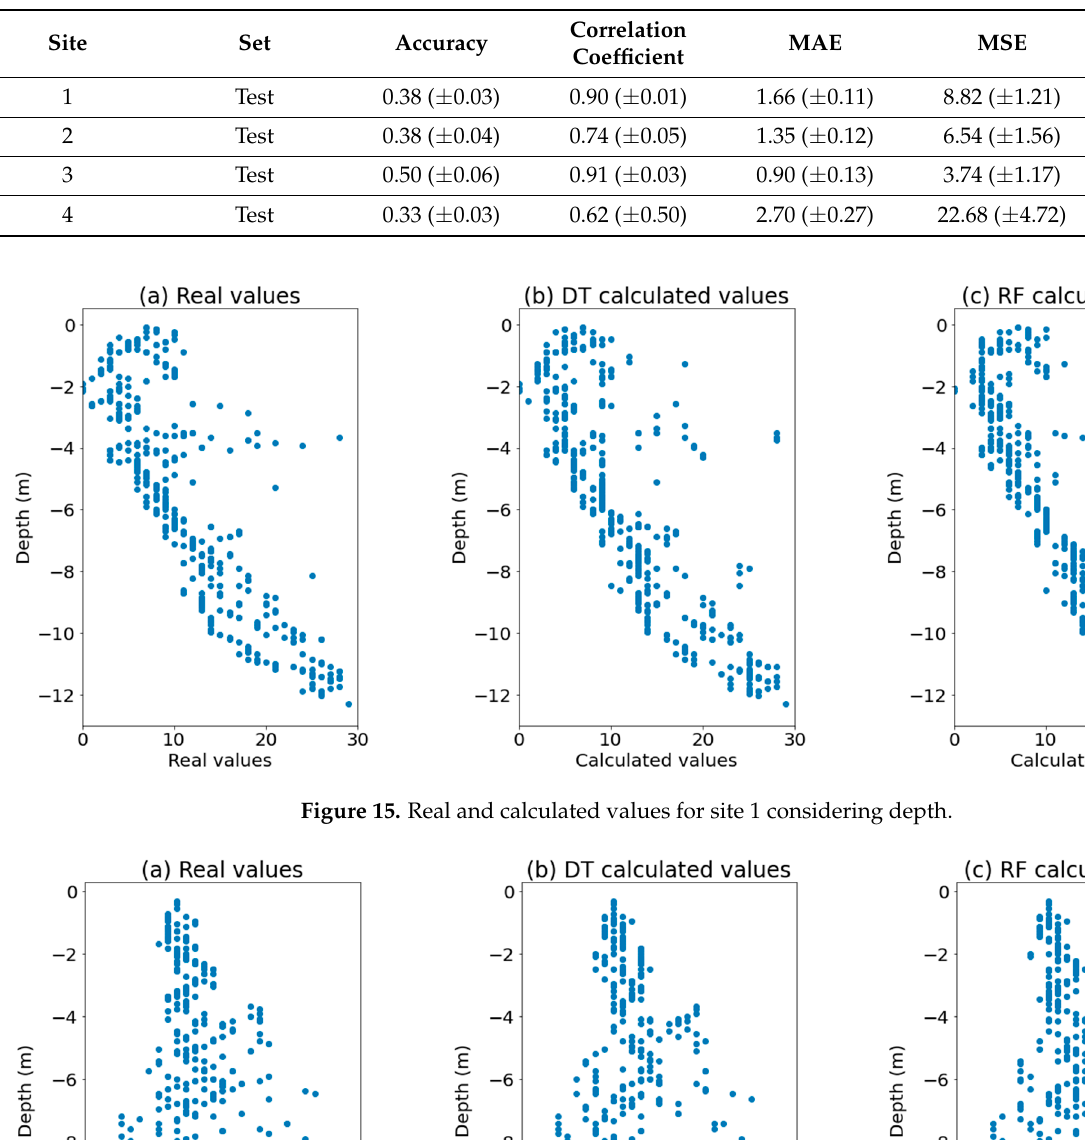
Table 14. Correlations obtained for RFs with depth.